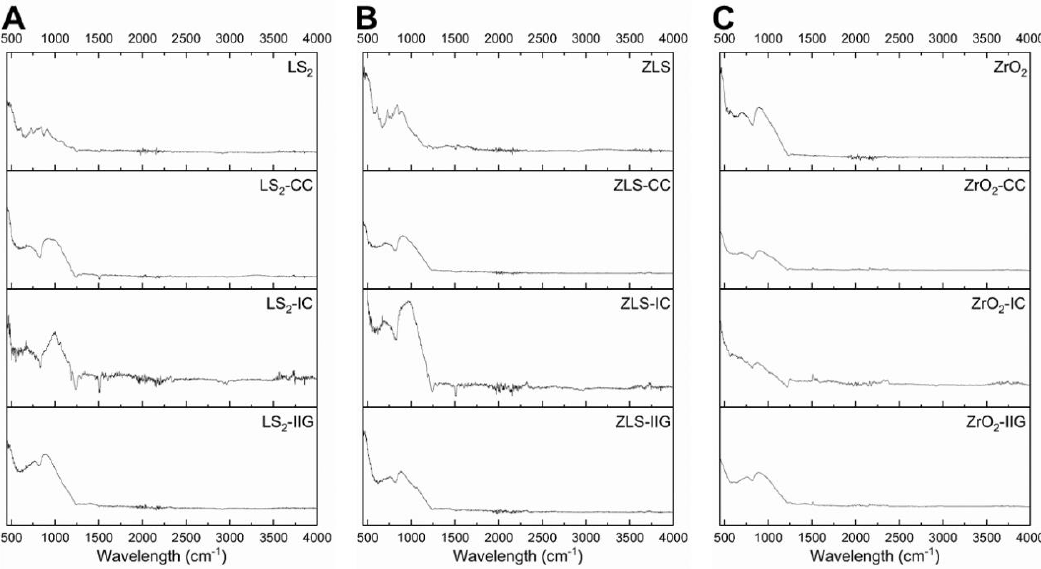
Figure 6. FT—IR spectra of the tested ceramics: ( A ) LS 2 ceramics; ( B ) ZLS ceramics; ( C ) ZrO 2 ceramics; before and after glazing with CC, IC, and IIG glazes.